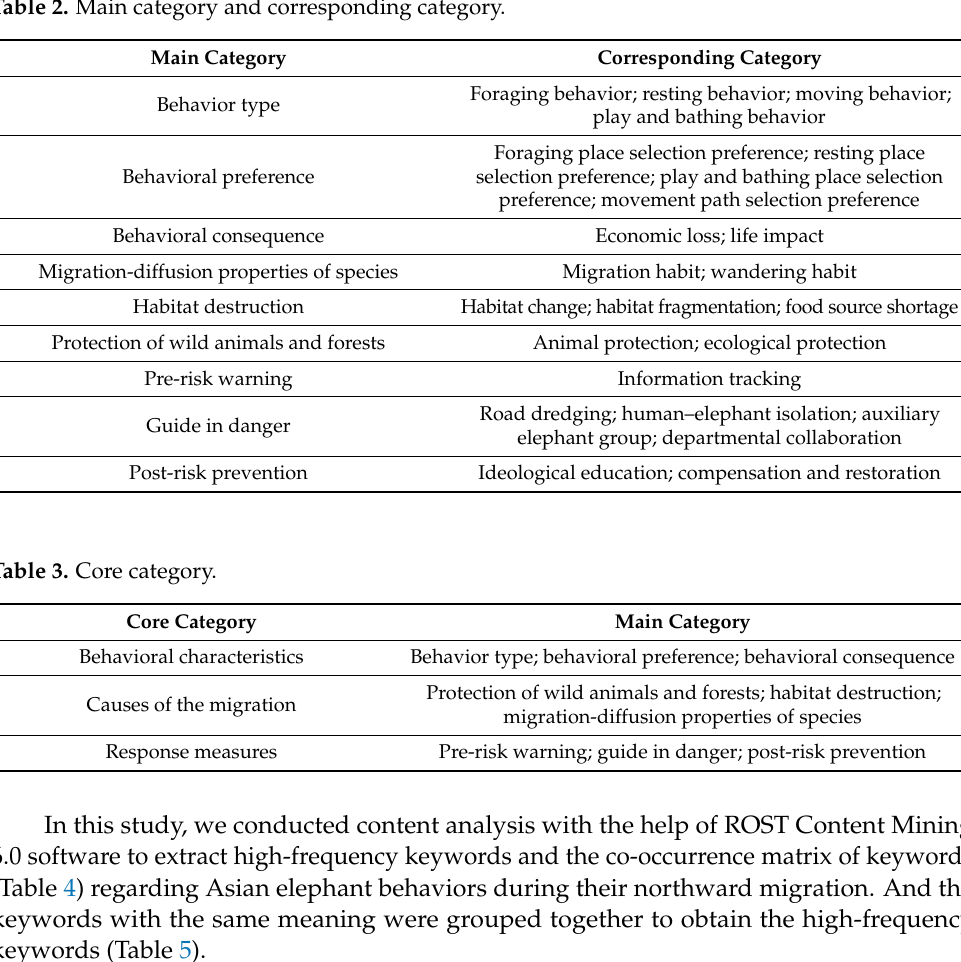
Table 2. Main category and corresponding category.